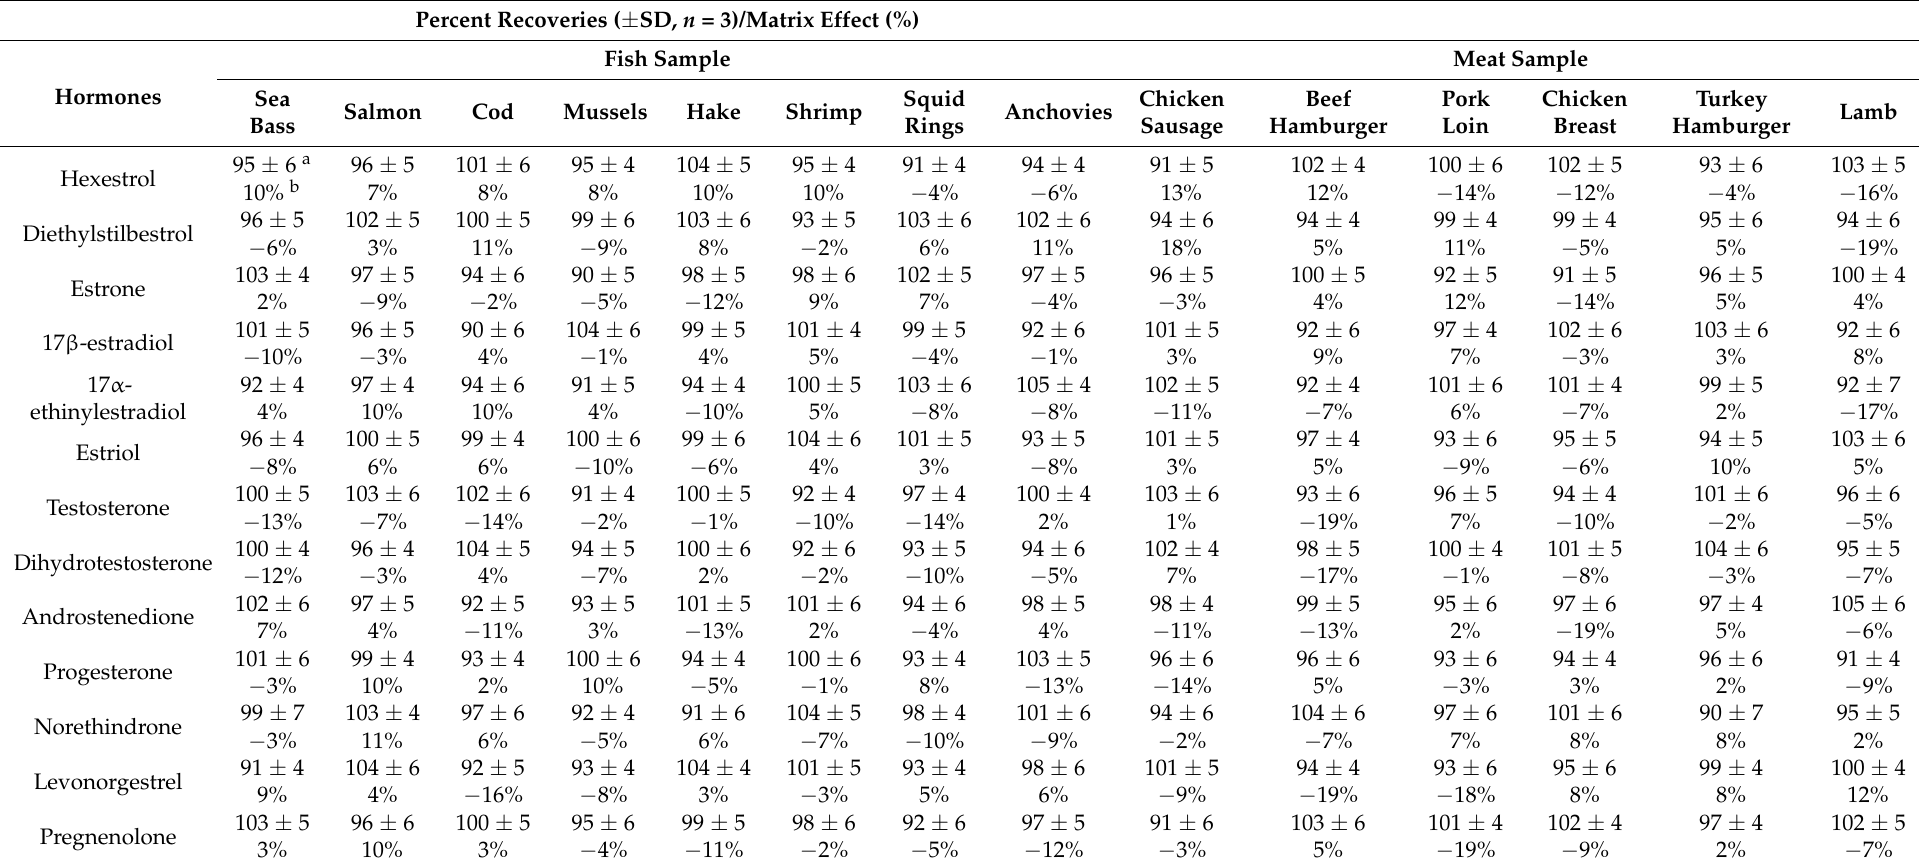
Table 2. Percent recoveries and matrix effect of hormones on the different types of fish and meat